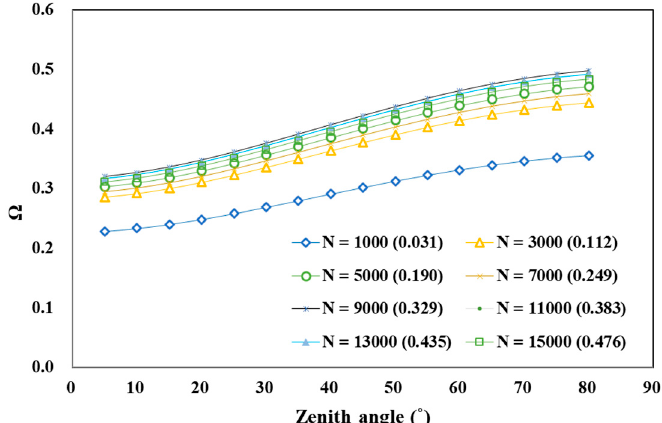
Figure 15. Clumping index variation with zenith angle for different tree density (crown coverage). N = total tree count within 4 ha. Values in brackets represent once-counted crown coverage, which varies according to the actual scenario. Other simulation parameters were as listed in Table 2, column 3.